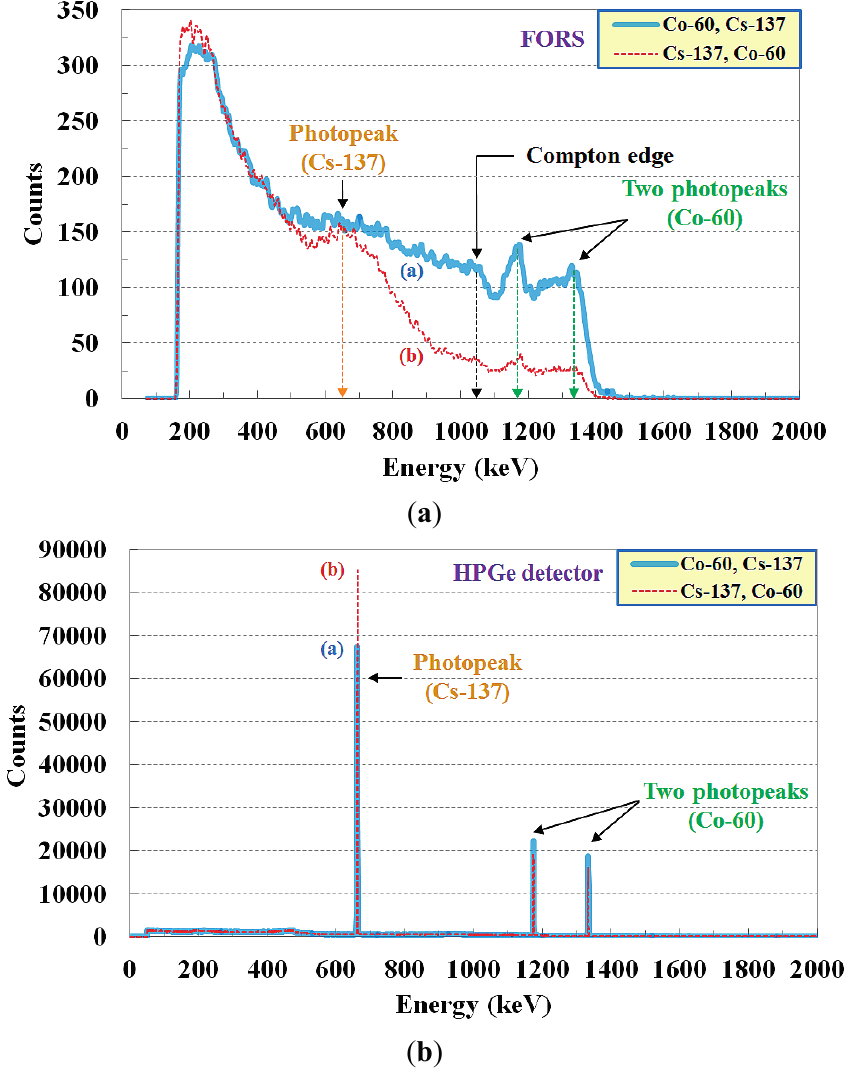
Figure 6. Gamma-ray energy spectra measured by using ( a ) the FORS and ( b ) the HPGe spectroscopy detector when two radioactive isotopes were